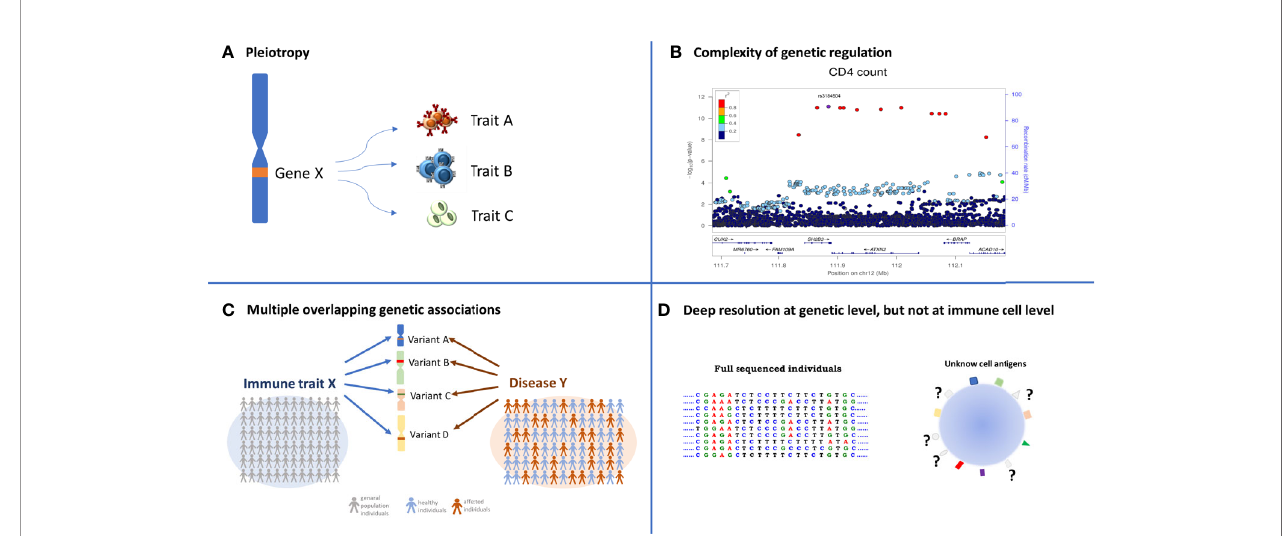
FIGURE 5 | Complexity in identifying overlapping association between immune trait and diseases. The four quadrants summarize the layer of dif fi culties that must be considered when the overlapping association approach is applied. (A) Pleiotropy: a speci fi c variant can regulate several traits; (B) the identi fi cation of the causal variant is often not immediate due to the high LD among variants. Each dot represents a genetic variant, LD among variants (expressed as r 2 ) is color coded and speci fi ed in the legend, the signi fi cance of the association, expressed as − log10[P value], is indicated in the left y axis, and the genomic positions in the x axis; (C) the identi fi cation of several independent genetic variants associated with the same immune cell X and the same disease Y (multiple overlapping genetic association) requires thousands of deeply immune pro fi led individuals, both from general populations to dissect immune cell genetic regulation, and from case- control studies to identify genetic regulation of diseases; (D) the genomic information of each individual is very deep being at single-base resolution, whereas the knowledge of all the proteins expressed on cell surface is far from being